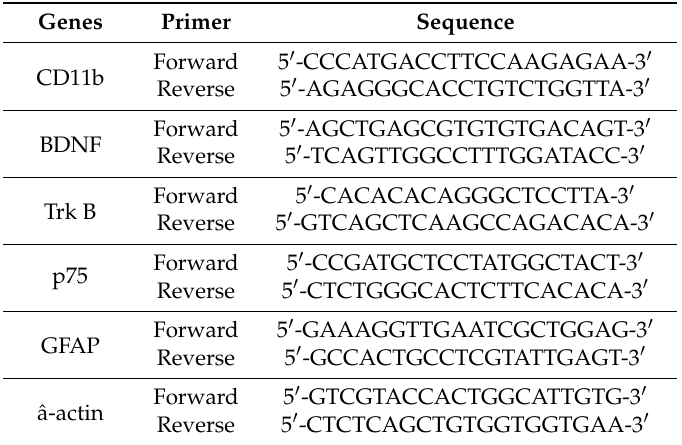
Table 1. Primer sequence used for real-time